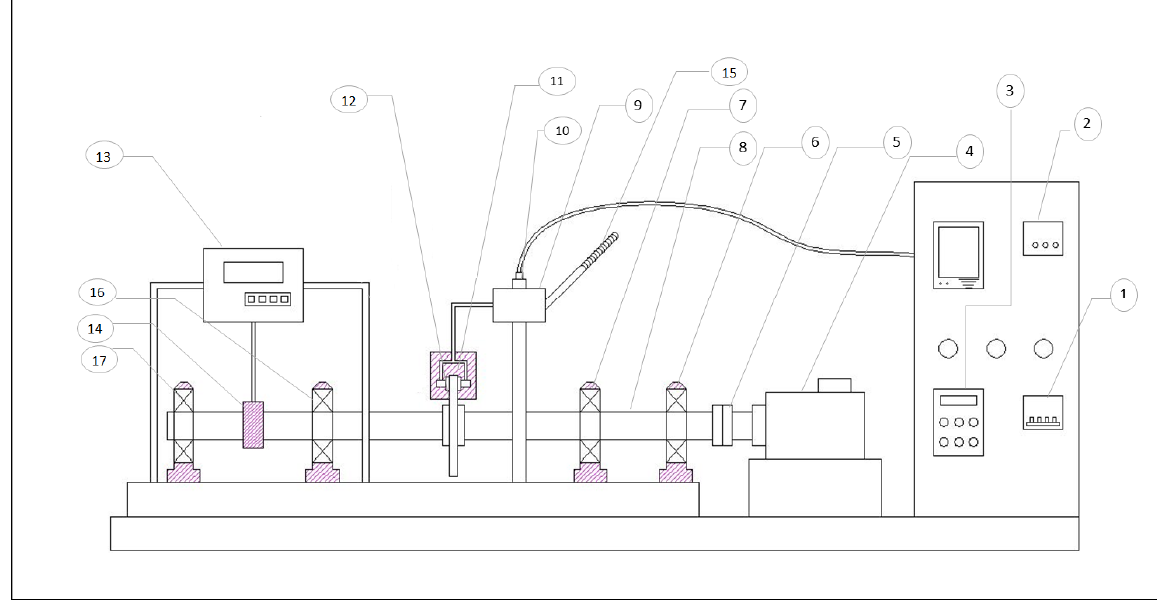
Figure 7. Schematic Diagram of Disc brake set-up.